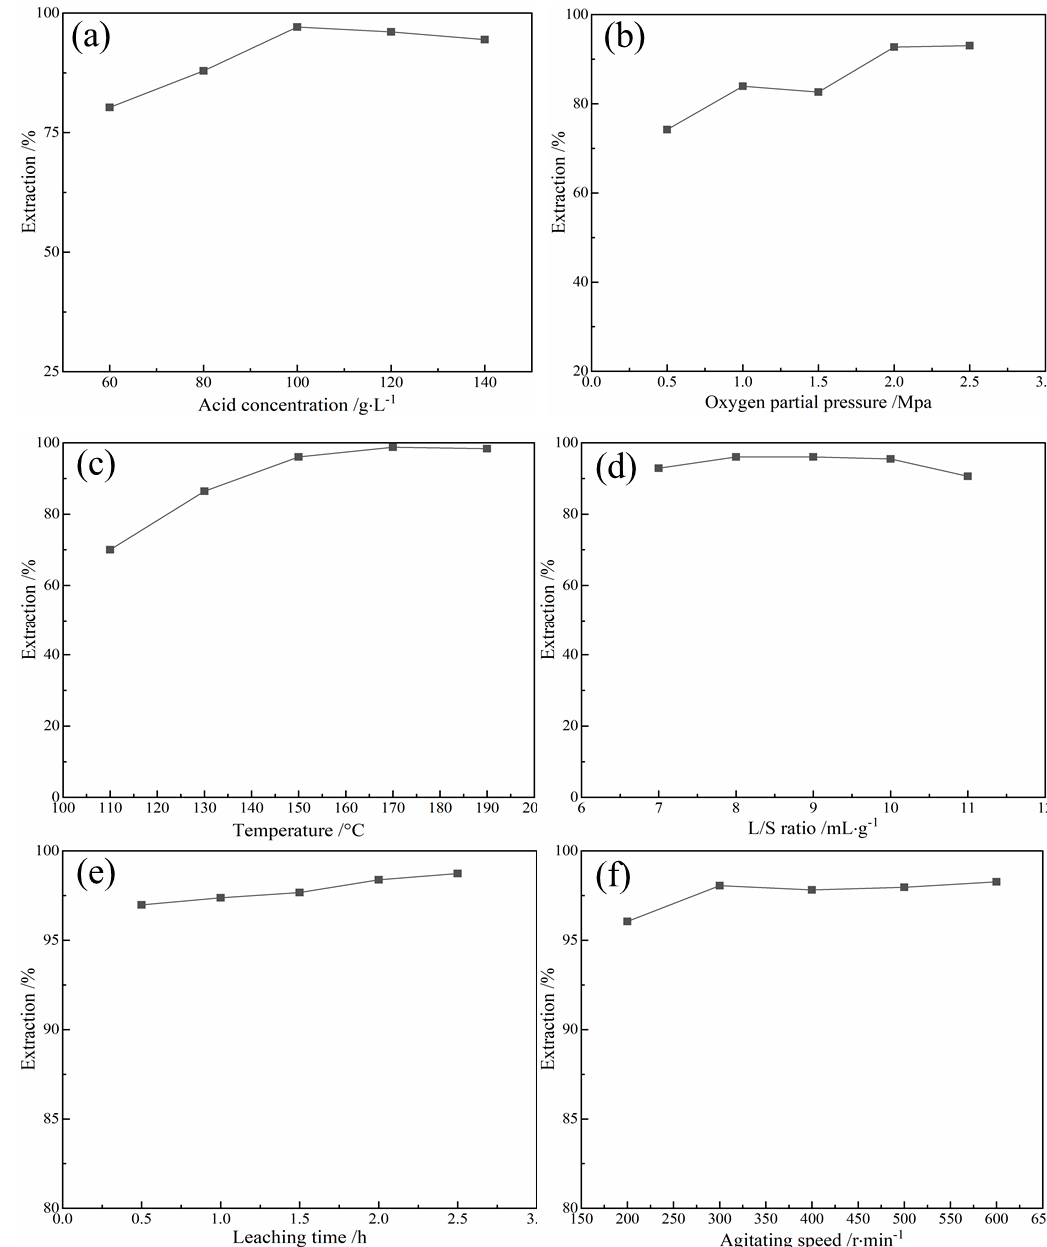
Figure 5. Effects of different acid leaching conditions: ( a ) acid concentration (150 °C, L/S = 8 mg/L, p O 2 = 2.0 MPa, 2 h, 200 r/min), ( b ) p O 2 (150 °C, L/S = 8 mg/L, [H 2 SO 4 ] = 100 g/L, 2 h, 200 r/min), ( c ) temperature ( p O 2 = 2.0 MPa, L/S = 8 mg/L, [H 2 SO 4 ] = 100 g/L, 2 h, 200 r/min), ( d ) L/S ratio (170 °C, [H 2 SO 4 ] = 100 g/L, p O 2 = 2.0 MPa, 2 h, 200 r/min), ( e ) leaching time (170 °C, L/S = 10 mg/L, p O 2 = 2.0 MPa, [H 2 SO 4 ] = 100 g/L, 200 r/min), ( f ) agitating speed (170 °C, L/S = 10 mg/L, p O 2 = 2.0 MPa, 2.5 h, 200 r/min).